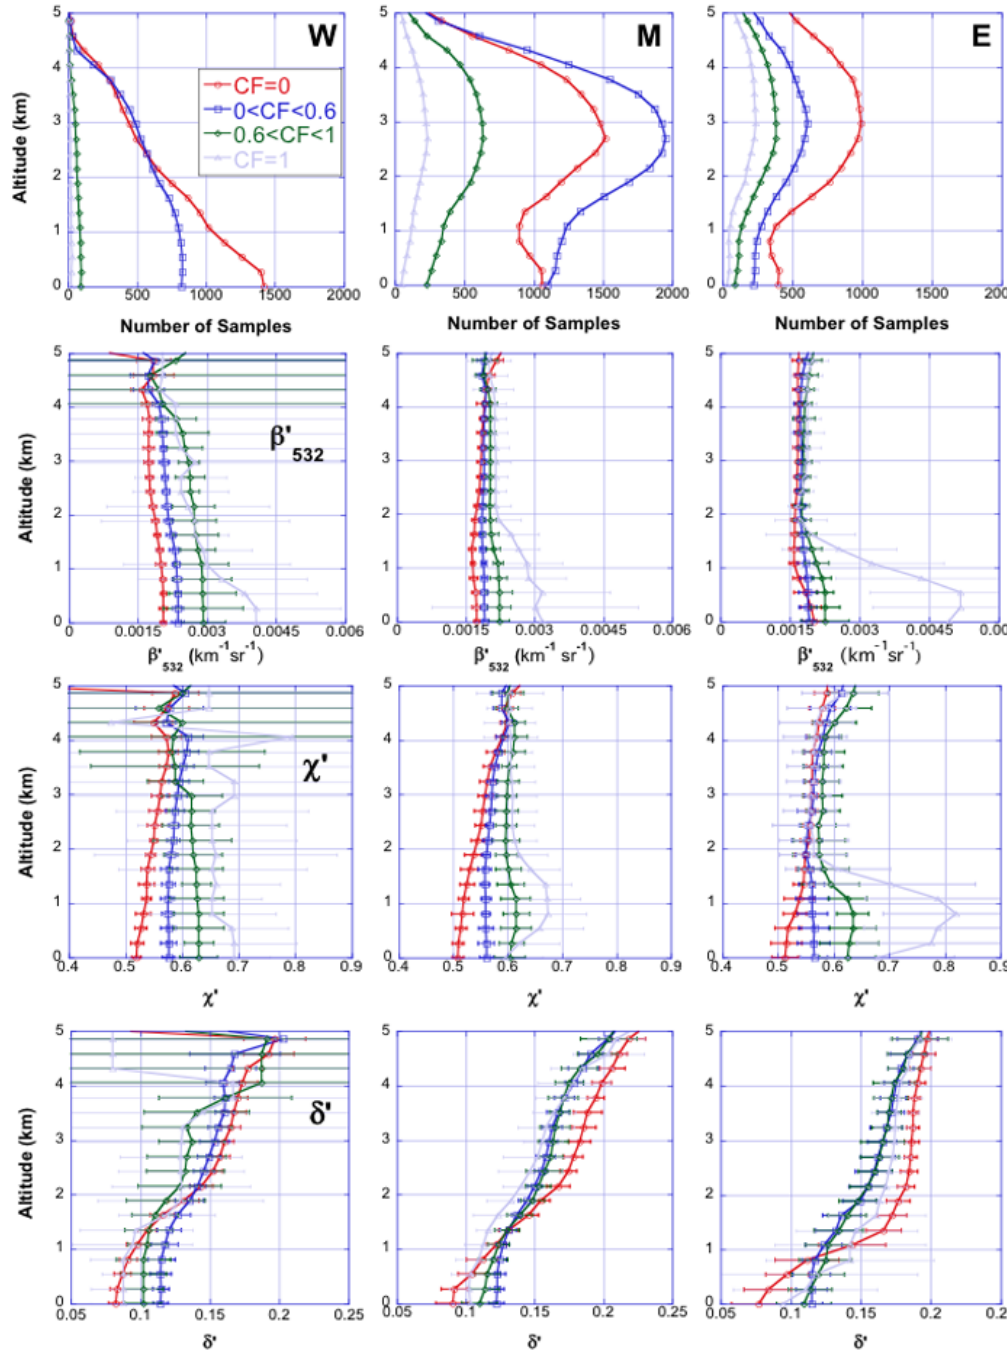
Fig. 4. Vertical profiles of dust properties for various cloud fractions at the 3 regions. Rows 1, 2, 3 and 4 are for frequency of occurrence, attenuated total backscatter coefficient at 532nm, β 0 , attenuated color ratio, χ 0 , and volume depolarization ratio, δ 0 , respectively. The left, 532 center, and right columns show the West, Middle and East regions, respectively. Results for different cloud fractions are indicated by different